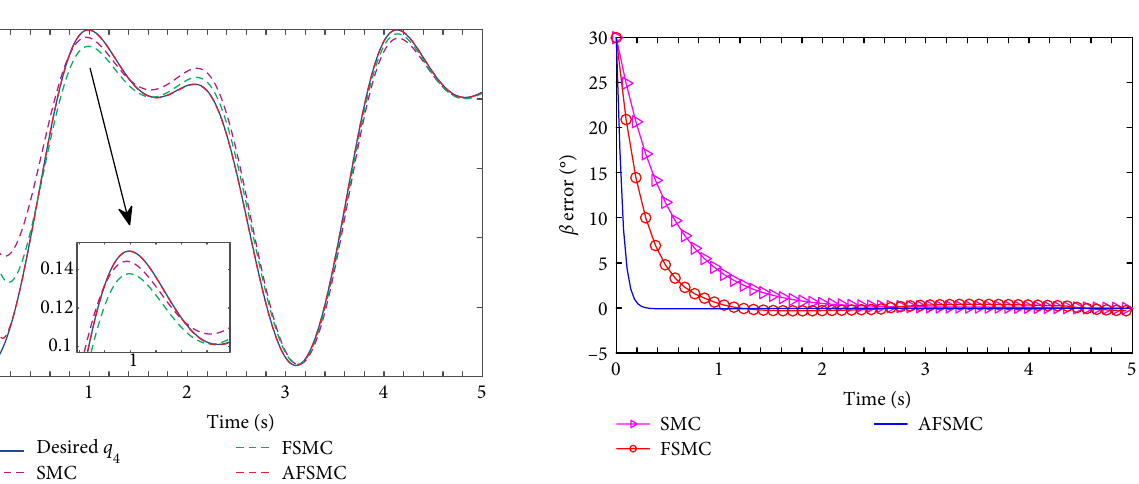
Figure 16: The tracking response of the fourth limb q